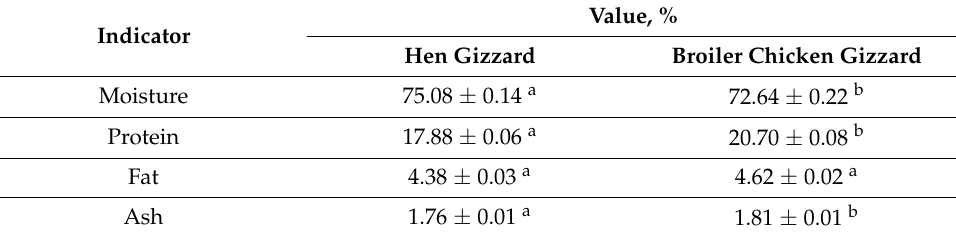
Table 4. Proximate composition of gizzards.